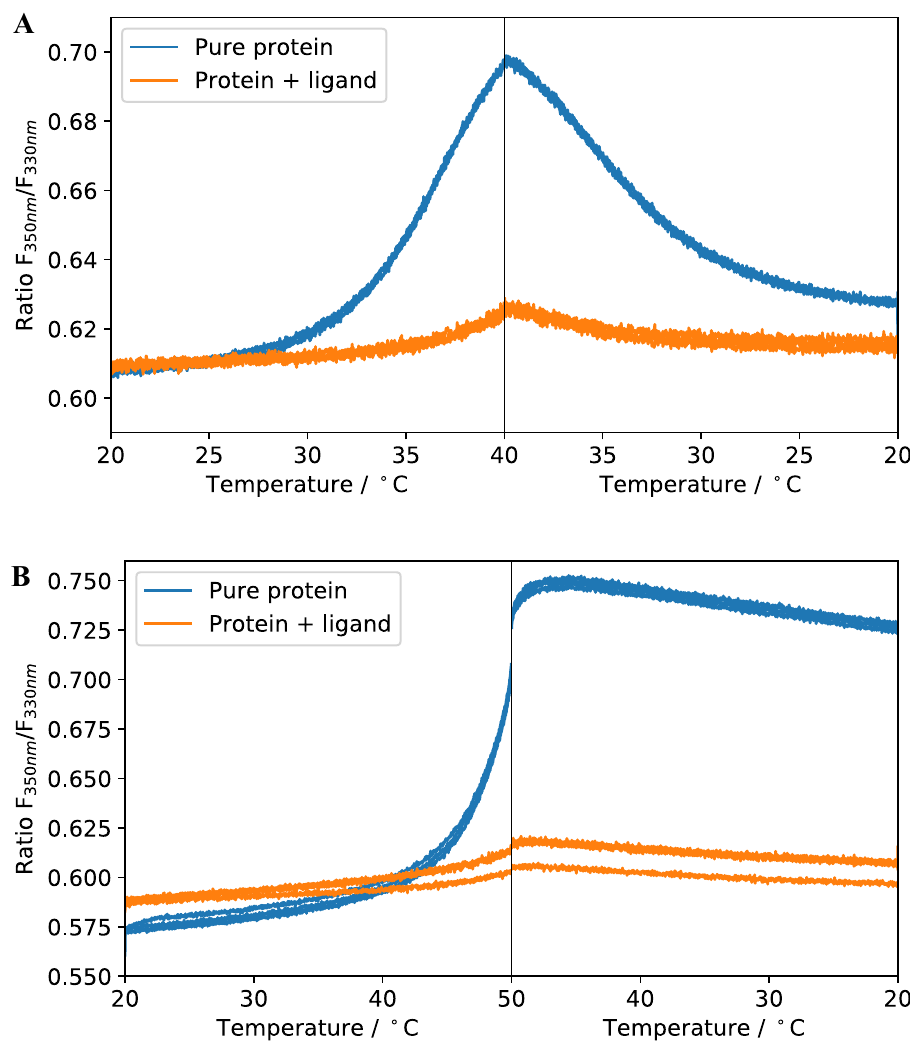
Figure 7. Refolding experiment with Pcs60 ( A ) and SS1 ( B ) with a maximum temperature set to the temperature at which K d values were extracted by isothermal analysis in Figs. 4 and 6 (40 °C for Pcs60 and 50 °C for SS1). Refolding experiment for Pcs60 up to 50 °C and SS1 up to 45 °C are shown in